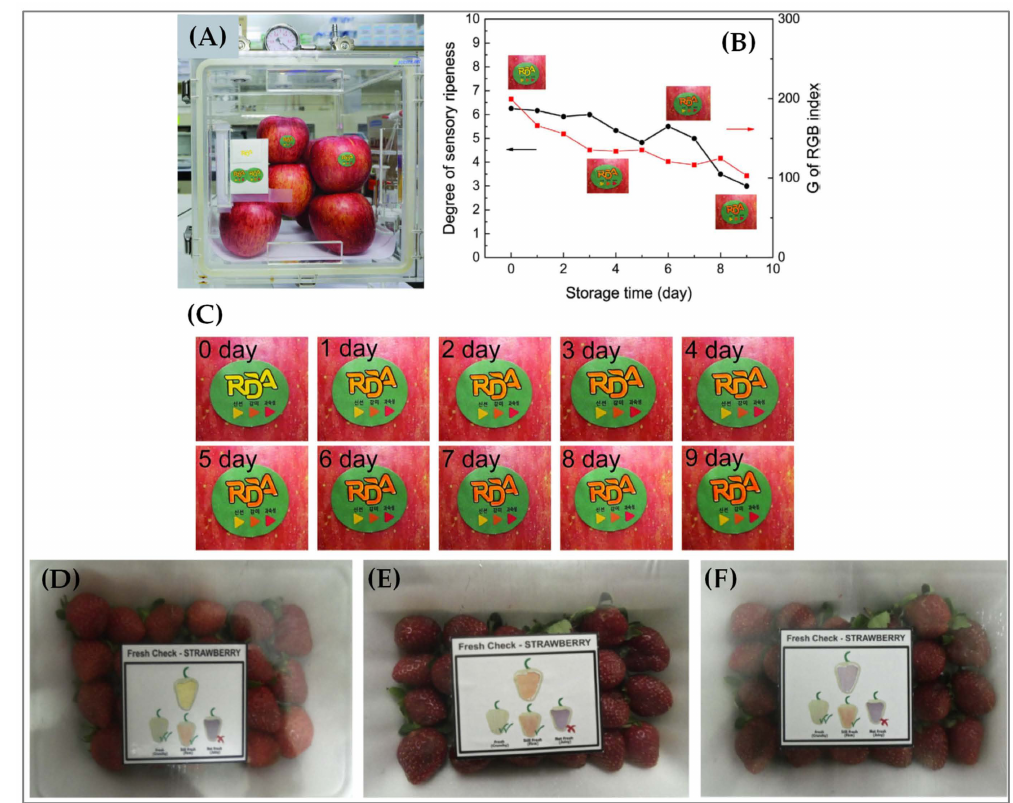
Figure 5. ( A ) Reaction setup for the detection of apple flavor using a sensor label, ( B ) degree of sensory ripeness and RGB index plot vs storage time, and ( C ) color changes in sensor label after exposure to apple flavors, reproduced with permission from ref. [38]. Application of color ripeness indicator for strawberry, ( D ) yellow for fresh (crunchy), ( E ) orange for medium (firm), and ( F ) purple for not fresh (juicy), reproduced from ref.